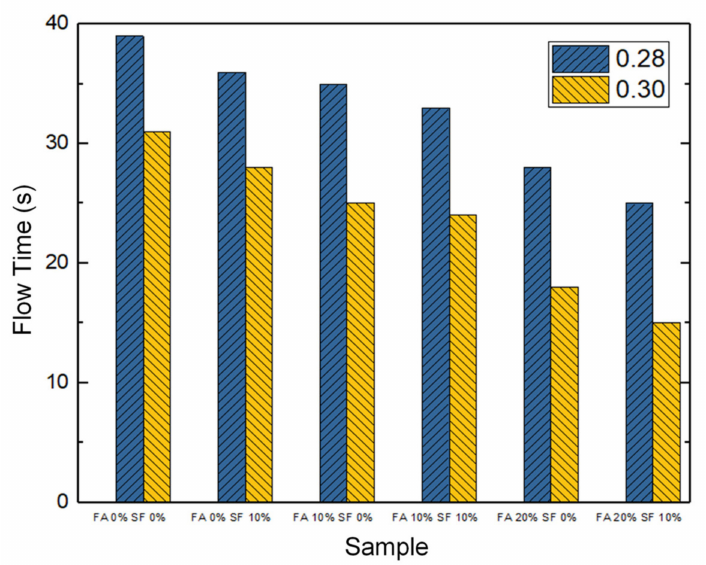
Figure 4. The time taken to flow through the V-shaped funnel by 12 HPC samples with a water/binder (W/B) ratio of 0.28 or 0.30. Note: FA = fly ash; SF = silica